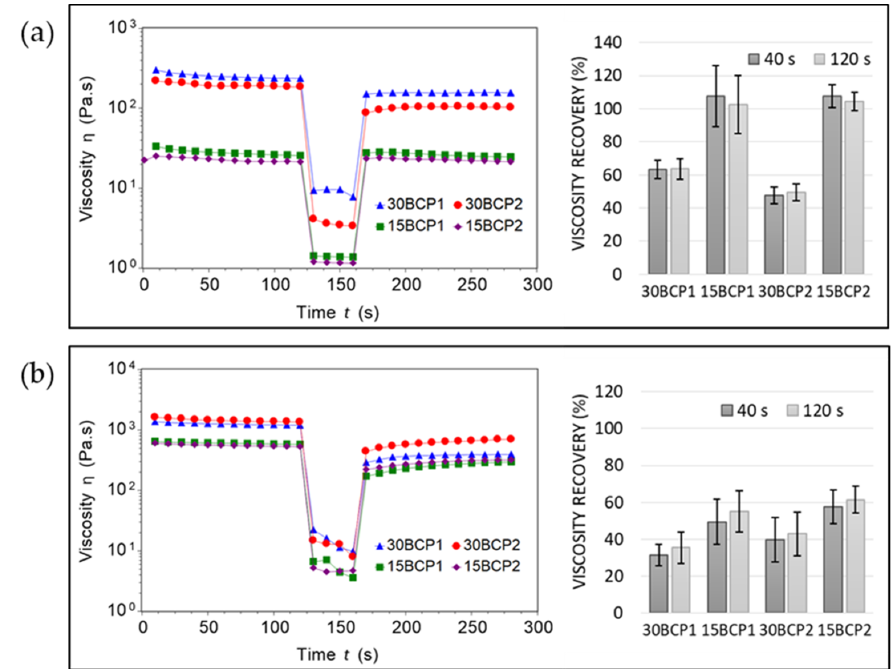
Figure 3. SFM test and viscosity recovery (%) at 37 °C ( a ) and 23 °C ( b ).